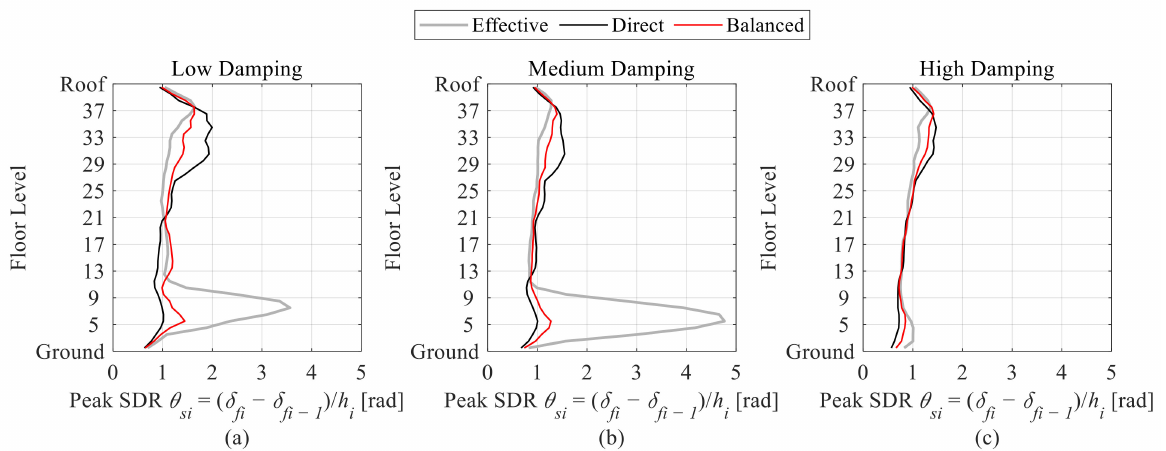
Figure 10. Comparison of peak SDRs based on nine different retrofit schemes in the X-loading direction, ( a ) low damping level, ( b ) medium damping level, ( c ) high damping